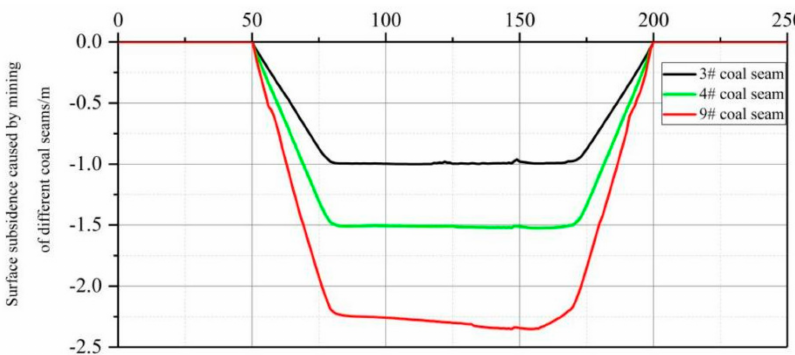
Figure 22. Surface subsidence caused by the mining of different coal